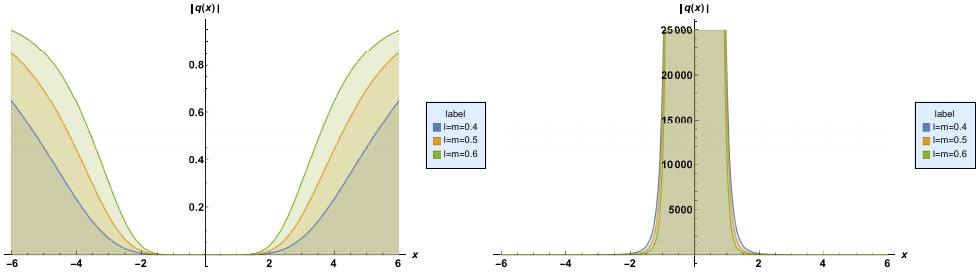
Figure 8. Profiles of stationary dark and singular solitons,